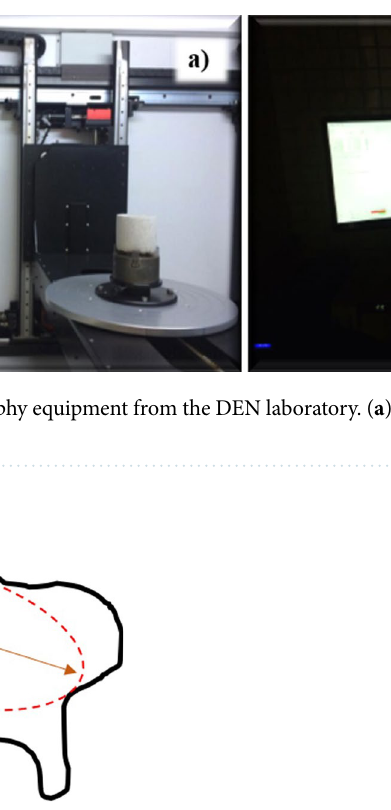
Figure 5. Representation of the ellipse allocation method to obtain orientation